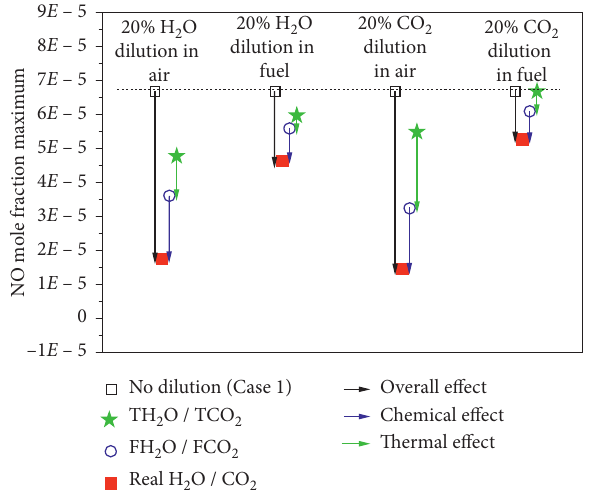
Figure 9: Peak NO mole fractions of CH flame with and without 20% H 2 O and 20% CO 2 dilution: a s � 50 s − 1 , L � 2cm